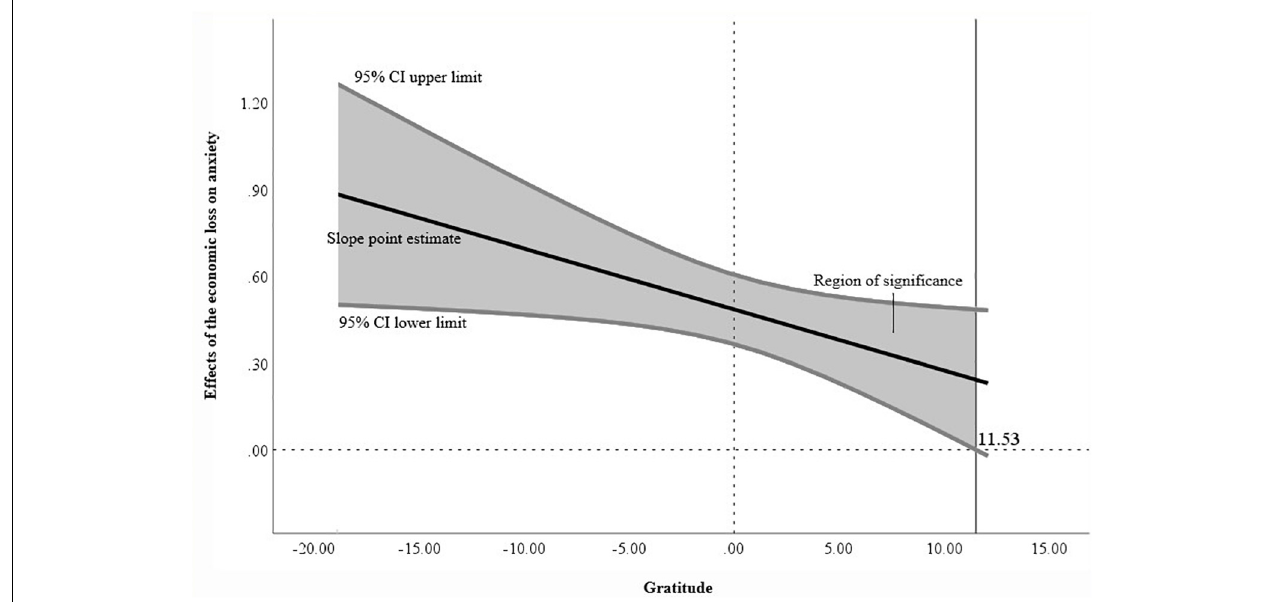
FIGURE 2 | Johnson-Neyman analysis graph of the moderation effect of gratitude in first survey.